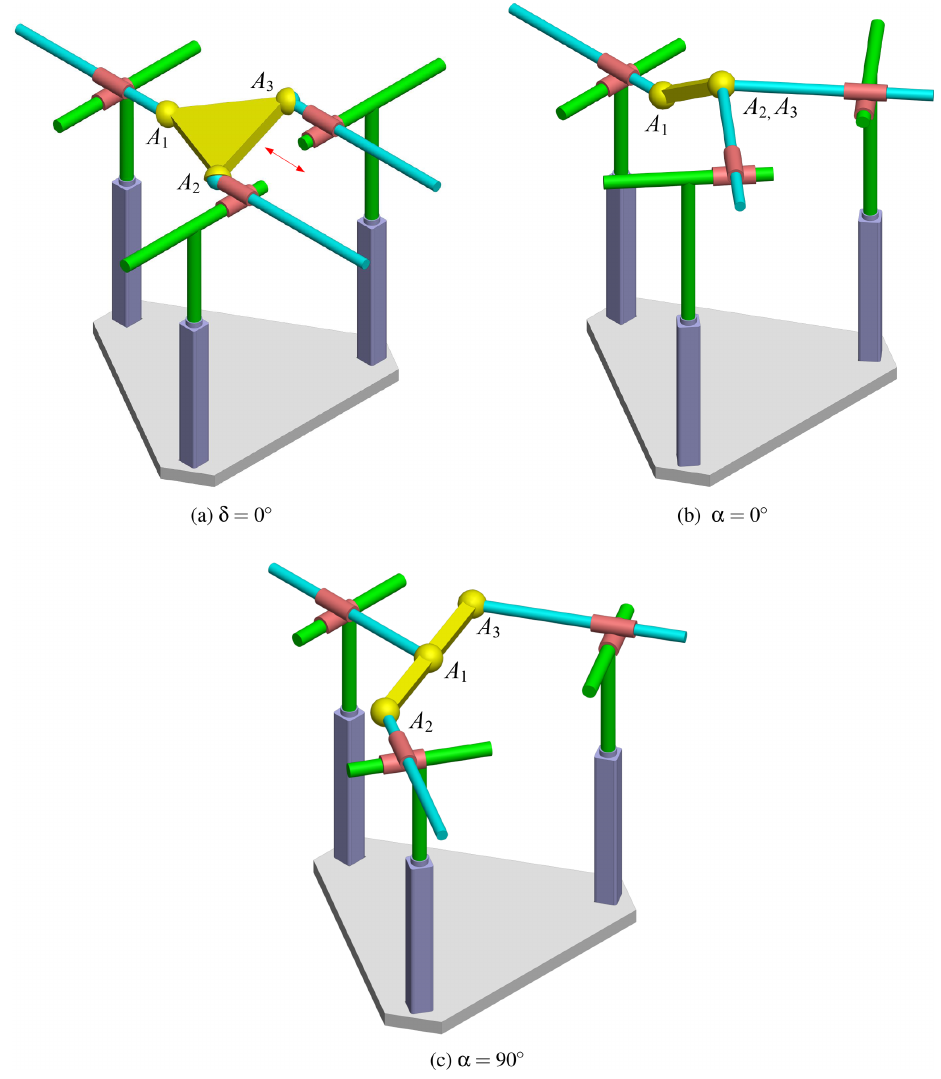
Figure 8. Three singular shapes of 3-PPPS parallel kinematics machine.